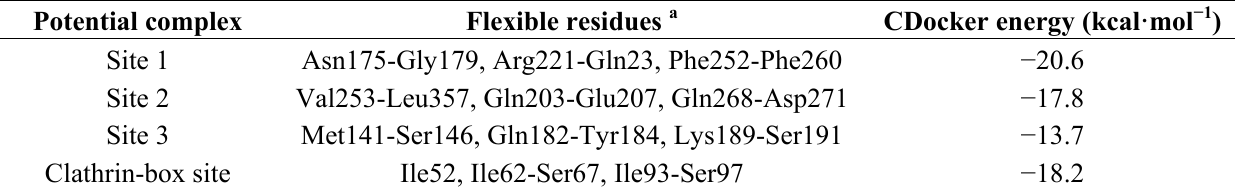
Table 1. Calculated CDocker energies from the final step for the flexible docking protocol of 1 into potential binding sites 1, site 2, site 3 and the clathrin-box site of the CTD. Potential